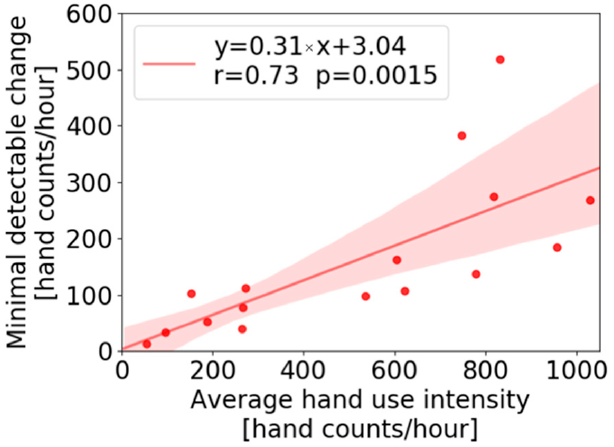
Figure 9. Minimal detectable change in hand use intensity that can be detected with respect to average daily intensity over three weeks of wearing, at a significance level of 0.05, plotted versus average use intensity across the three weeks of wearing. The shaded area represents the 95% confidence interval of the regression line.